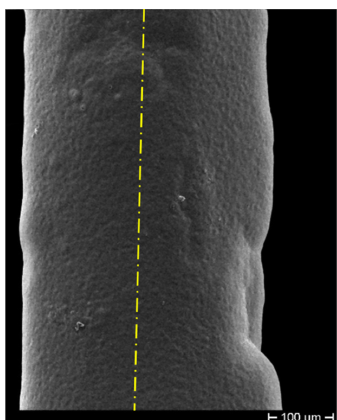
Figure 1. Non-uniform deposition due to a non-in-axis positioning of the cathode. The yellow dash-dotted line shows the actual position of the cylindrical Pb anode axis.